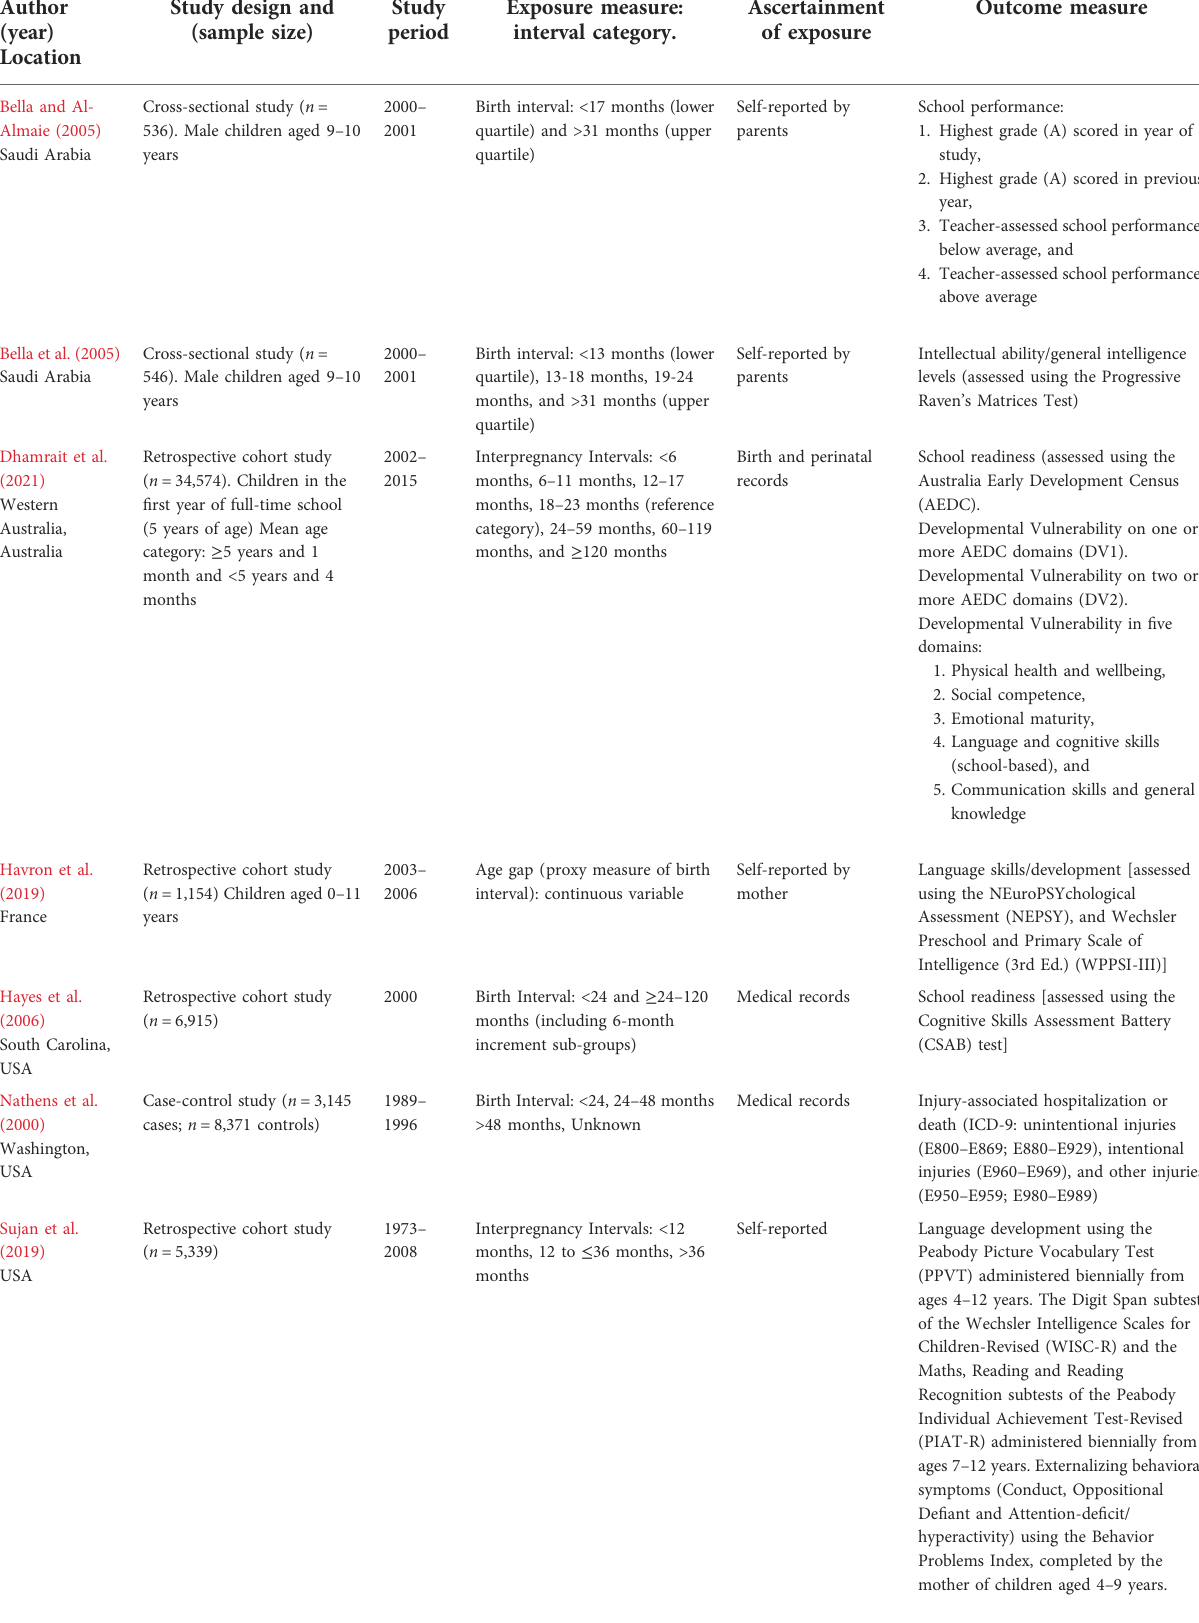
TABLE 1 Characteristics of studies included in the systematic